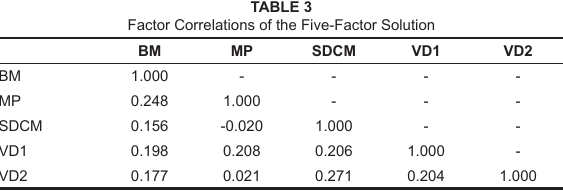
TABLE 3 Factor Correlations of the Five-Factor